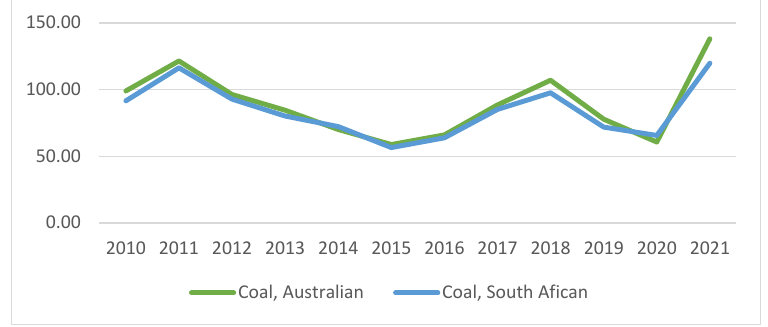
Figure 3. Coal Price (USD/mt) [19].